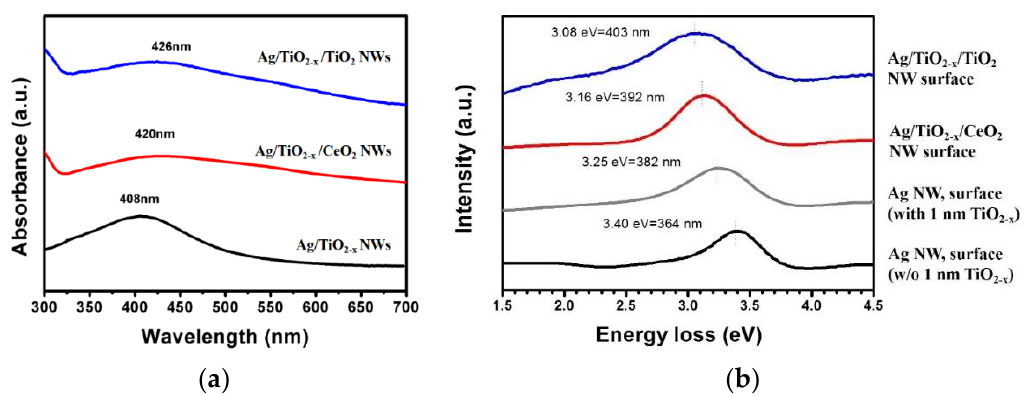
Figure 6. Nanowire optical properties: ( a ) UV-visible absorption spectra, and ( b ) low loss region of EELS.